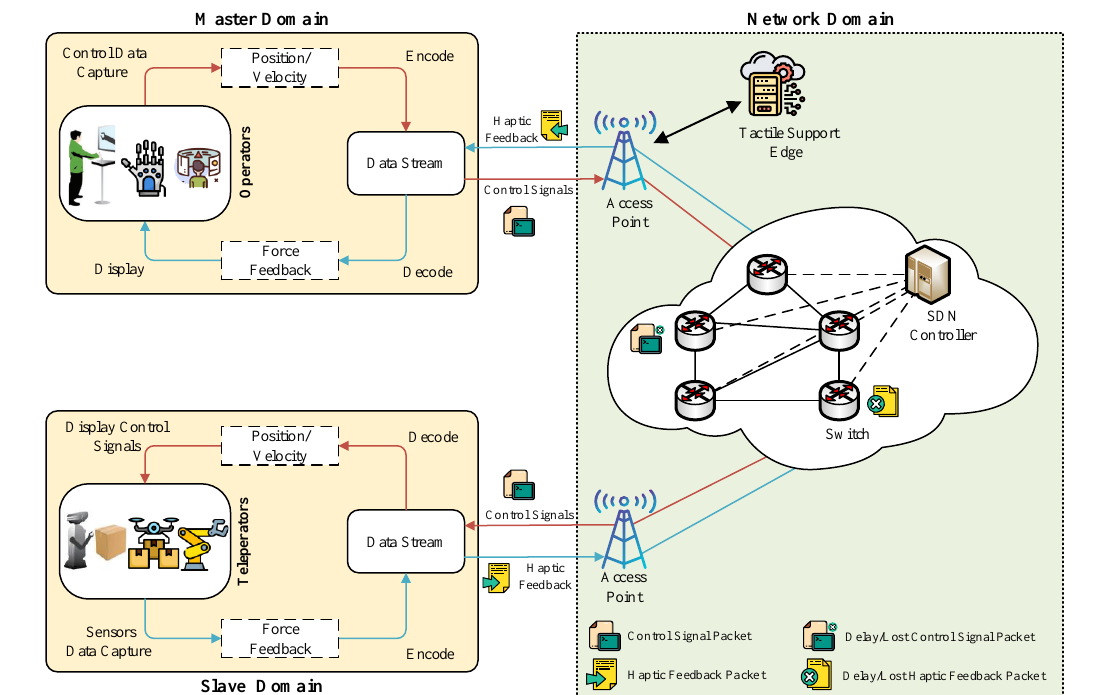
Figure 4. Indepth overview of the proposed virtual testbed